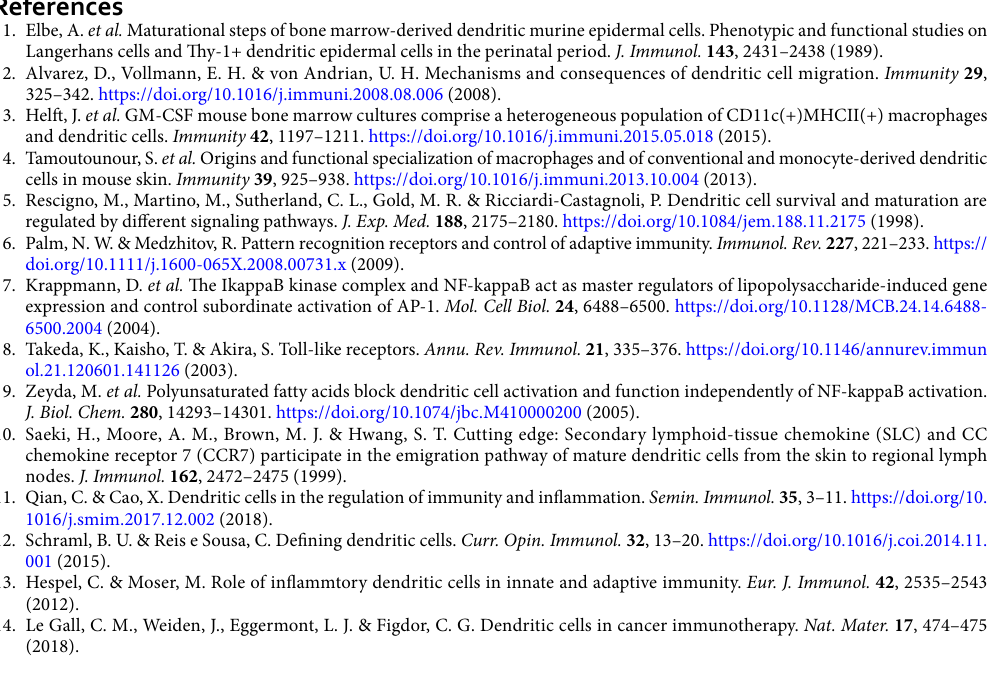
Figure 5. Shear stress increases the expression of MHC class I and CD86 on DCs. ( A ) BMDCs were seeded at a density of 10 6 cells/mL in the microfluidic device in the presence or absence of 1 μg/mL LPS. After 24 h, BMDCs were either unexposed (static) or exposed to shear stress for 3, 6, or 12 h. Activation of BMDCs was analyzed by flow cytometry. ( B , C ) Representative histogram with geometric mean fluorescence intensity (MFI) ( B ) and relative mean fluorescence intensity (MFI) ( C ) of the MHC class I molecule are shown. ( D , E ) Representative histogram ( D ) and relative MFI ( E ) of CD86 are shown. ( F , G ) Representative histogram ( F ) and relative MFI ( G ) of PD-L1 are shown. The MFI of BMDCs under static conditions was set to 1.0. Data represent the means ± standard errors of the mean. * p ≤ 0.01; *** p ≤ 0.001; NS, not significant. CTR, LPS-untreated control. Representative data from at least three independent experiments are